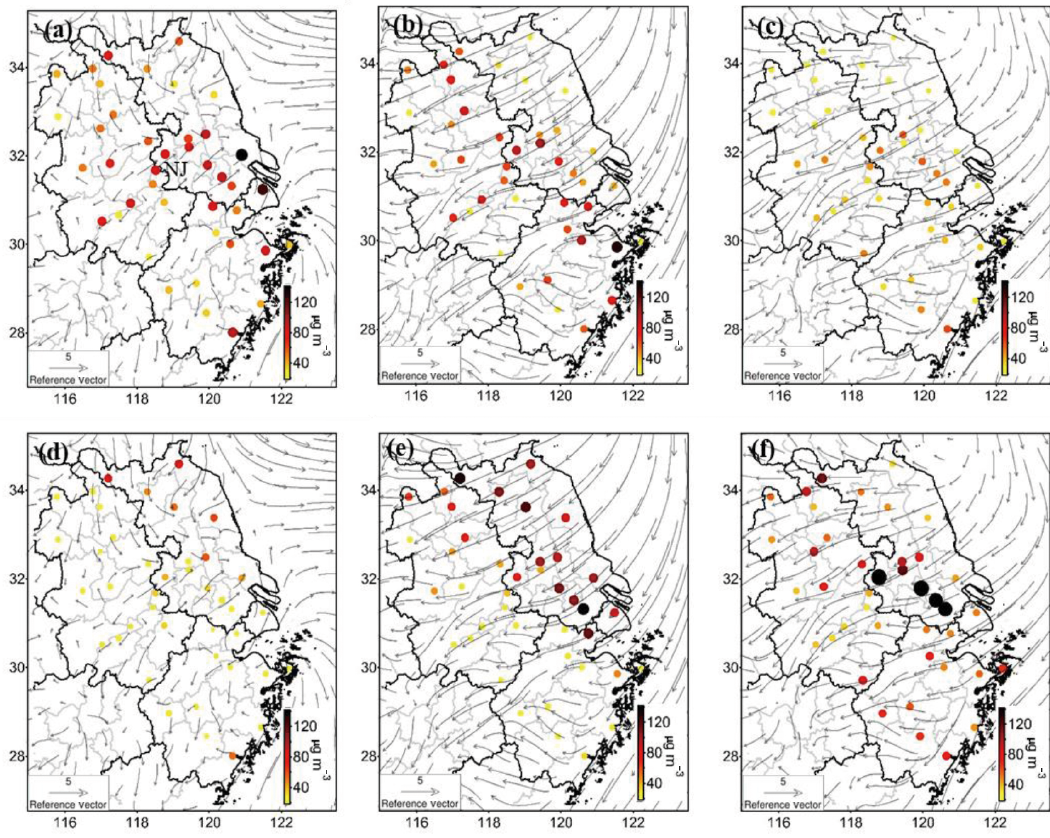
Figure 4. Spatial distributions of wind and observed hourly concentrations of PM 2 . 5 (a–c) and PM 2 . 5–10 (d–f) over the Yangtze River Delta at 12:00LT on 21, 22 and 23 March